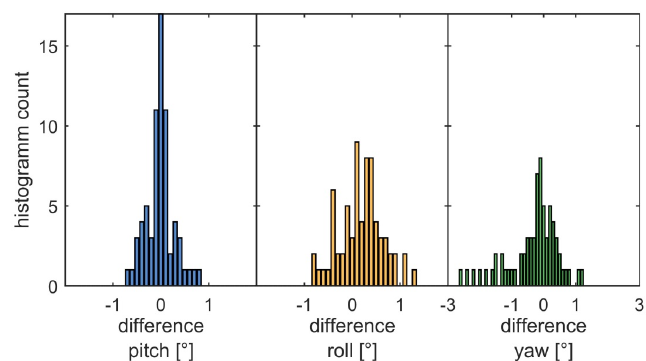
Figure A1. The differences between the indirect (SfM-computed) angles and those from the GPS/INS for the photographs of Flight 2 after the applied mounting calibration.